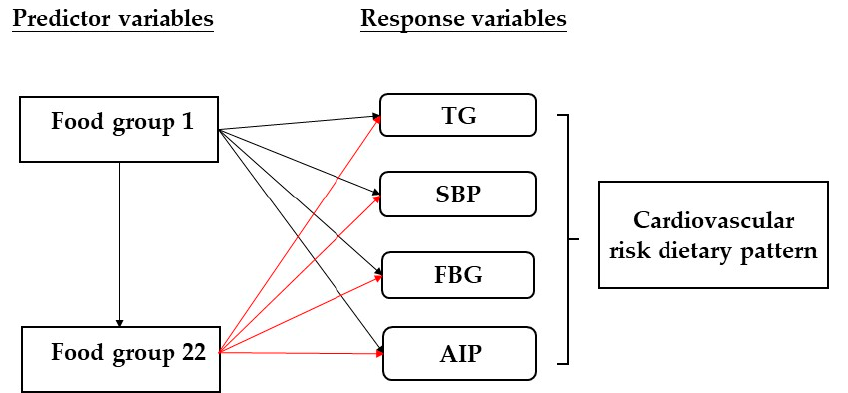
Figure 2. Cardiovascular risk dietary pattern derived from reduced rank regression model. TG: triglycerides, SBP: systolic blood pressure, FBG: fasting blood glucose, AIP: atherogenic index of plasma.